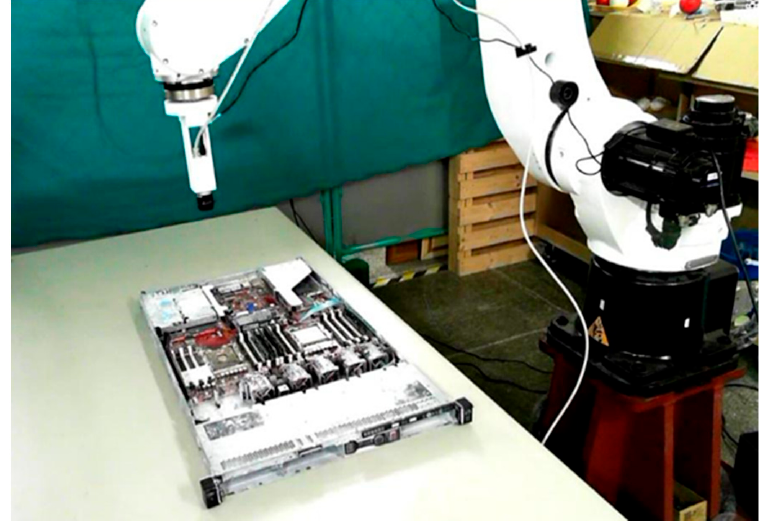
Figure 11. Camera shooting pose at the positioning artificial marker.